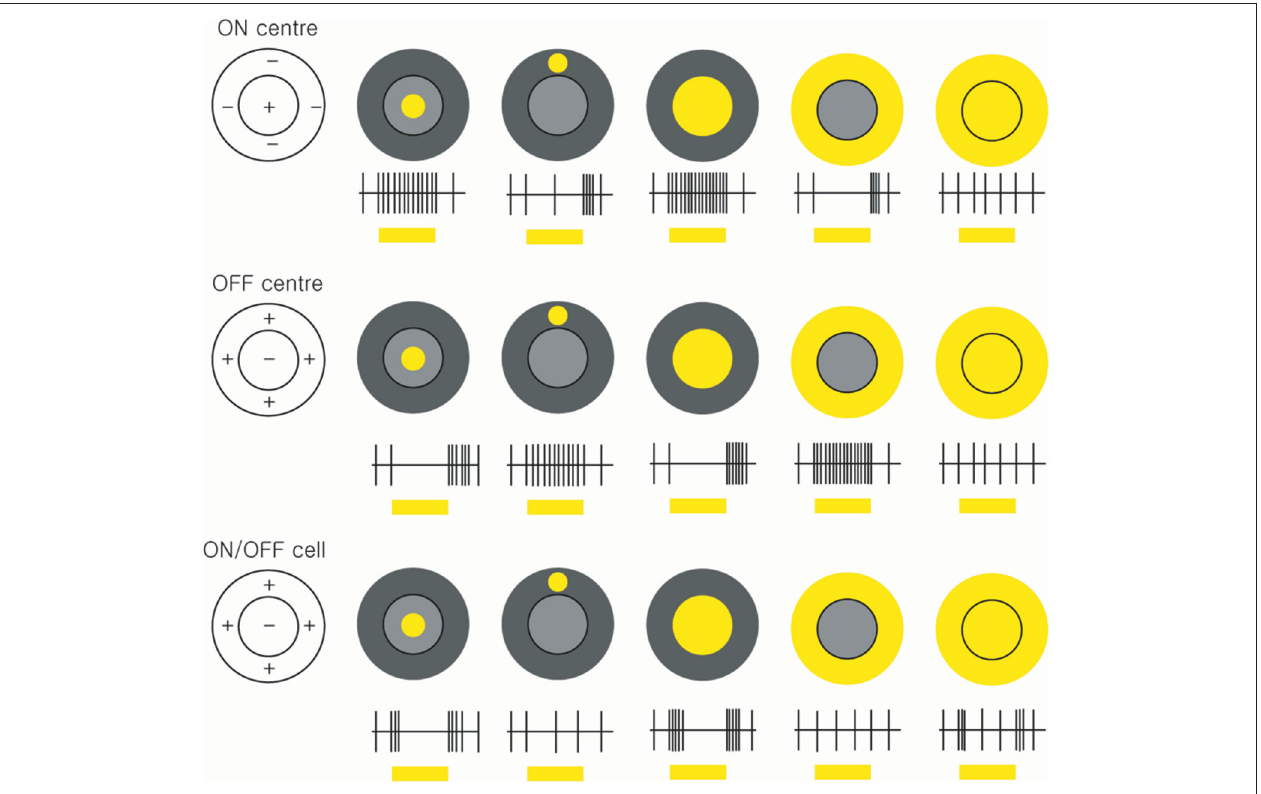
FIGURE 3 | Receptive fields and responses of ON-centre, OFF-centre, and ON/OFF retinal ganglion cells. ON-centre RGCs (upper panels) increase their rate of discharge when the light illuminates in the centre. However, when the surround field is illuminated, the ON-centre RGCs are suppressed. OFF-center RGCs respond when the light turns off (middle panels). ON/OFF cells are triggered briefly when the light turns on or off (lower panels) ( by Ungsoo S. Kim ).